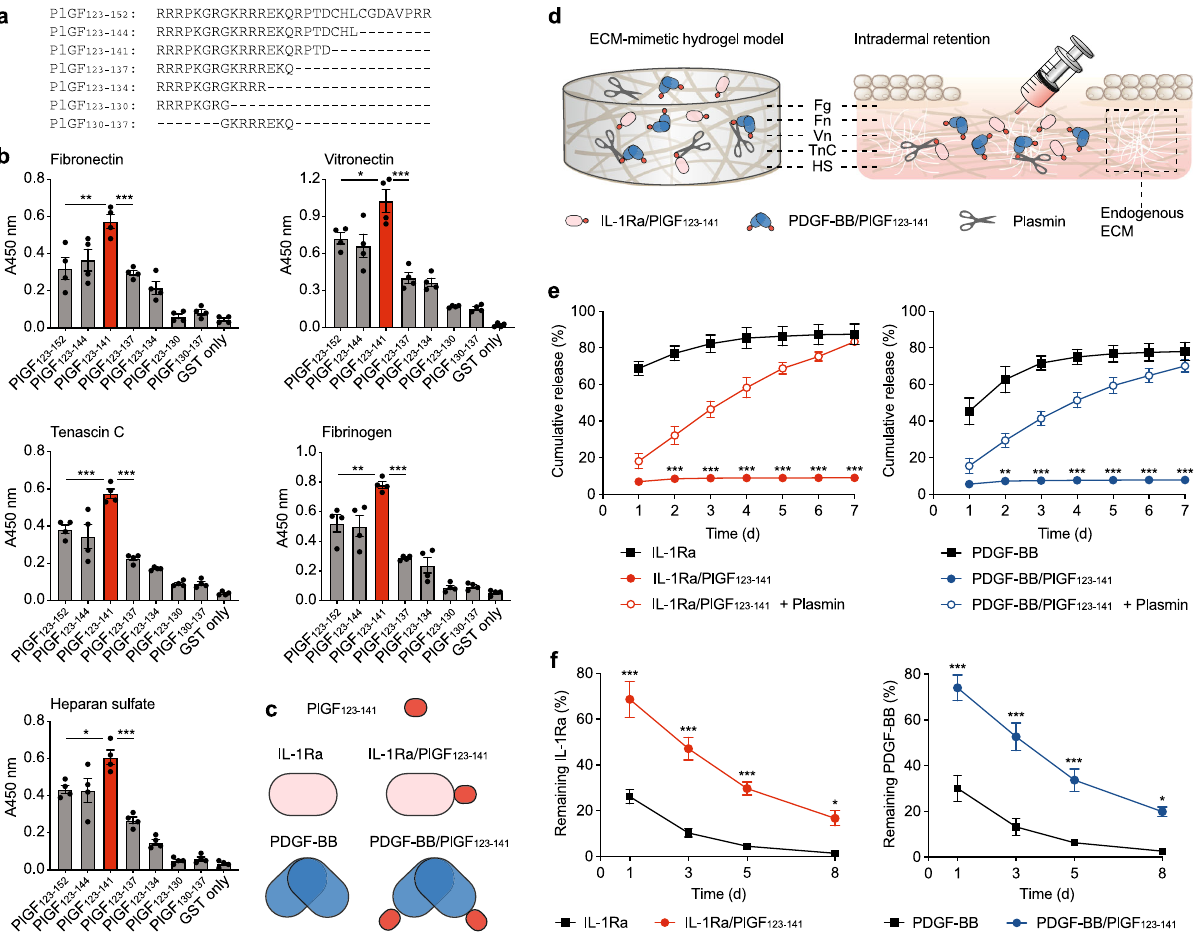
Fig. 2 PlGF 123 – 141 -fused IL-1Ra and PDGF-BB strongly bind ECM and are retained in skin tissue. a Amino-acid sequences of PlGF fragments fused